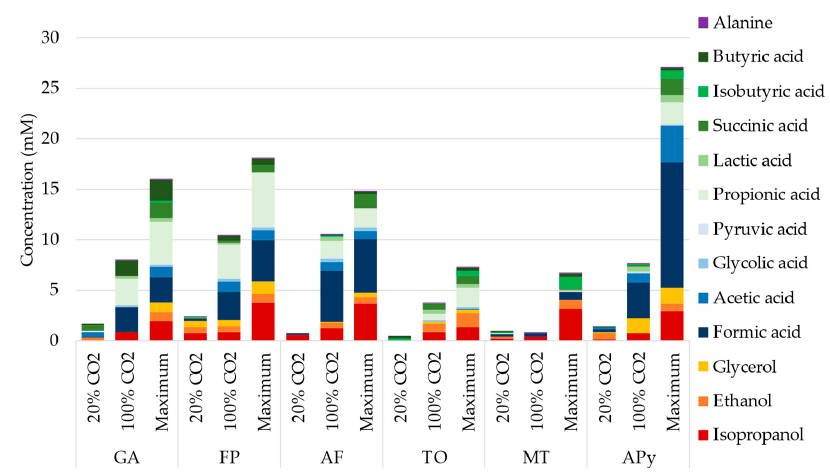
Figure 3. Organic molecule production measured by HPLC, NMR, and GC ‐ MS during the 33 days of experiment with the 6 selected strains. The cumulative bar plots represent the production during the 13 days with 20% CO 2 in the gas sparging, during the 20 days with 100% CO 2 in the gas sparging, and the maximum concentration reached during all the experiments. The succinic acid and lactic acid were omitted for AF and FP at 20% due to overlapping peaks on HPLC data with the thiosulfate but added at 100% and maximum from NMR measurement on final sample. Overall, the total concentration of products was 4 to 10 times higher at the end of the 20 days at 100% CO 2 than at the end of 13 days at 20% CO 2 . This difference in production is not related to longer cultivation period, as higher production per day was observed at 100% CO 2 (Supplementary Figure S3). APy showed the maximum organic production, reaching up to 12.4 mM of formic acid, 3.6 mM of acetate, 1.5 mM of glycerol, 1.6 mM of succinic acid, and 0.8 mM of lactic acid on day 16. A maximum of 3.7 mM of isopropanol and 5.4 mM of propionic acid were obtained by FP, 1.2 mM of isobutyric acid by MT, 0.35 mM of Glycolic acid by AF, 0.85 mM of ethanol by TO, and 2.2 mM of butyric acid by GA.